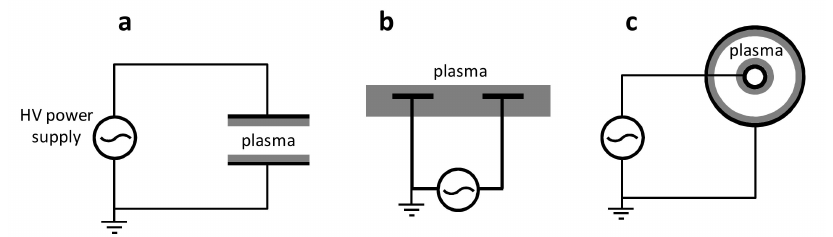
Figure 2. Three typical Dielectric Barrier Discharge (DBD) configurations: ( a ) parallel plate; ( b ) co-planar surface DBD; ( c ) co-axial DBD. The dielectric layer that covers the electrodes is represented in grey. Reprinted with permission from [19]. Copyright 2018 Elsevier.